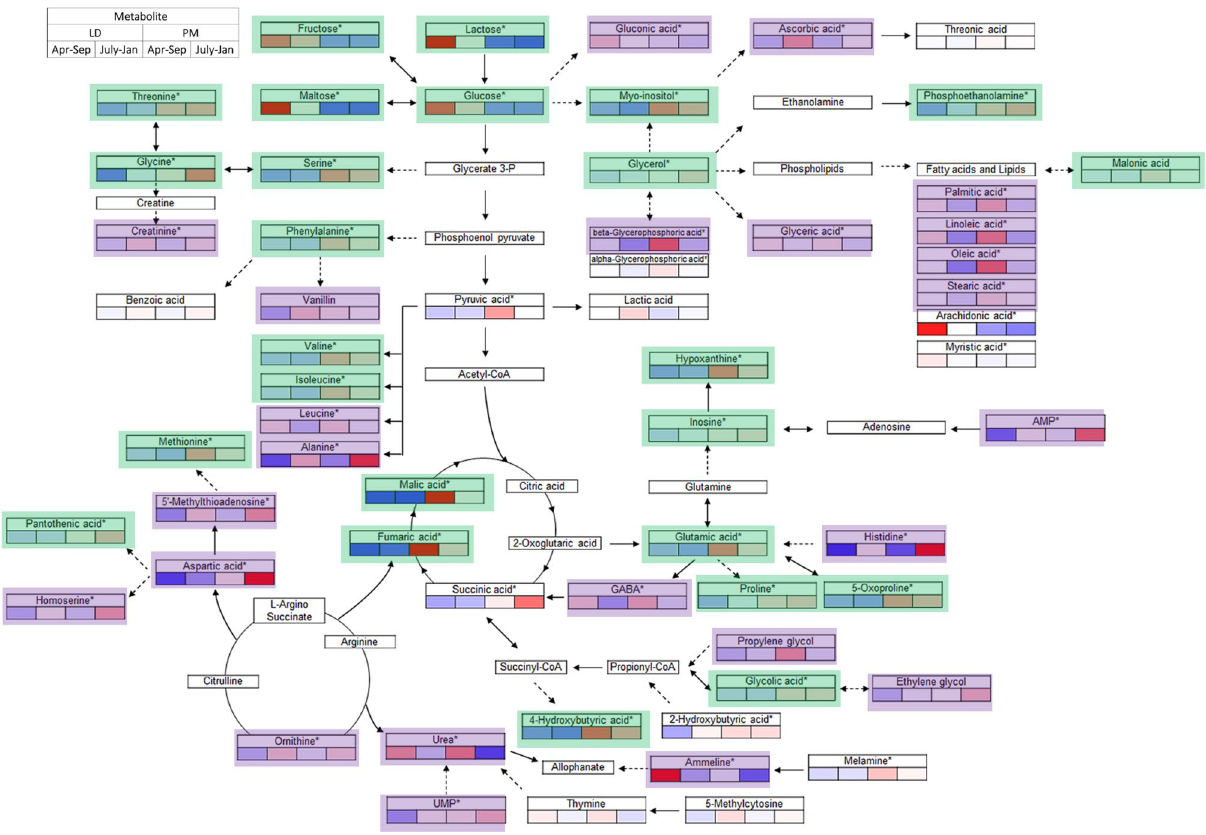
Figure 5. Pathway analysis of differentially affected metabolites and pathways in porcine LD ( longissimus dorsi ) and PM ( psoas major ) muscles from two production replicates. July–Jan: Pigs weaned in July 2016 and harvested in January 2017; Apr–Sep: Pigs weaned in April 2017 and harvested in September